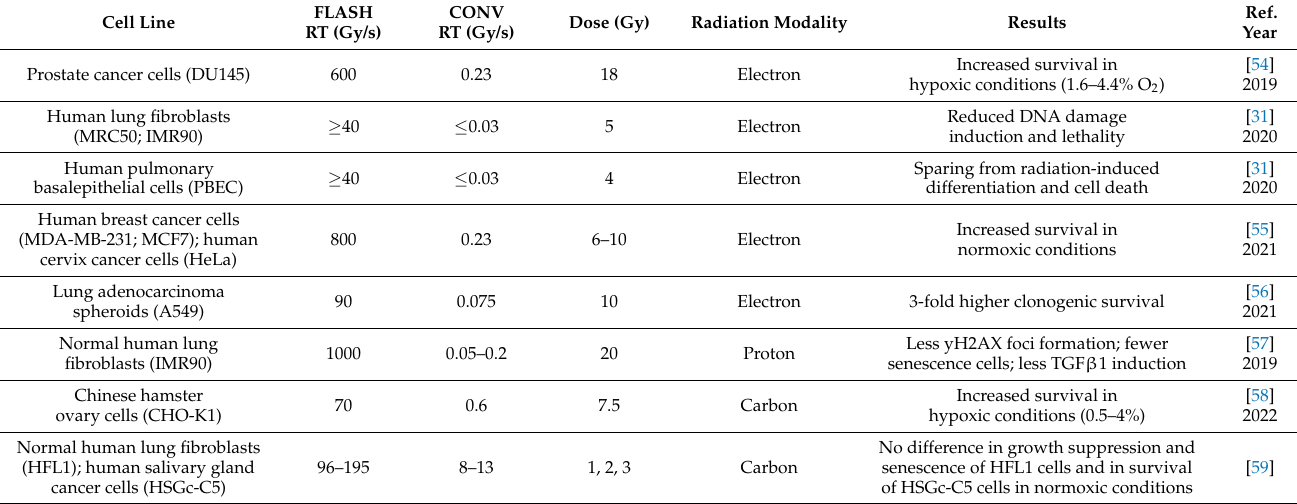
Table 2. Summary of in vitro studies showing a FLASH